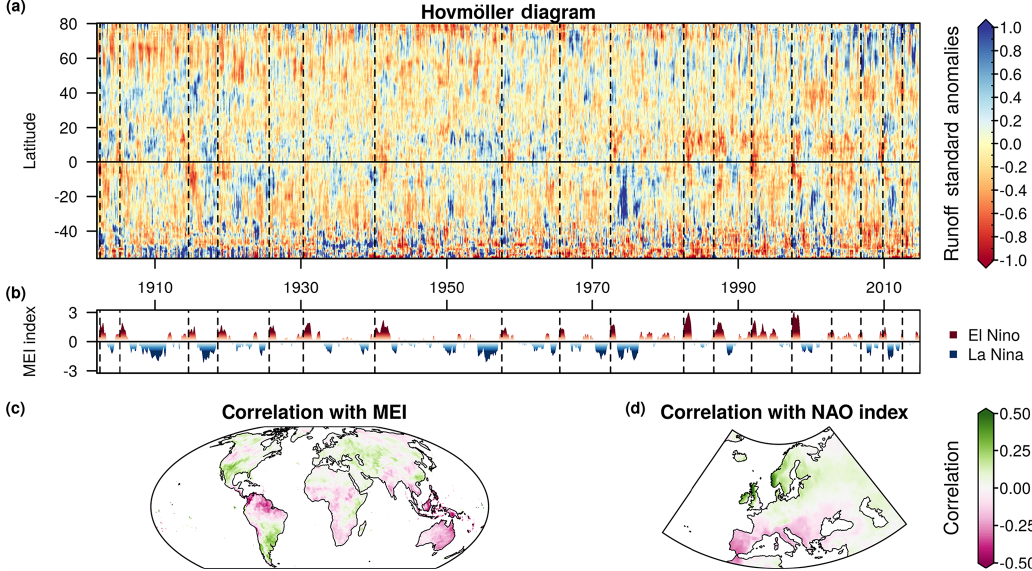
Figure 11. Interannual variability of runoff and its relation to modes of climate variability. (a) Hovmöller diagram of standard runoff anomalies (reference period 1902–2014). Vertical dashed lines indicate onset of El Niño events. (b) Time series of the multivariate ENSO index (MEI). Red and blue shades characterize the intensity of El Niño and La Niña conditions respectively. (c) Correlation of the MEI with monthly runoff anomalies. (d) Relationship of European runoff anomalies with the North Atlantic Oscillation